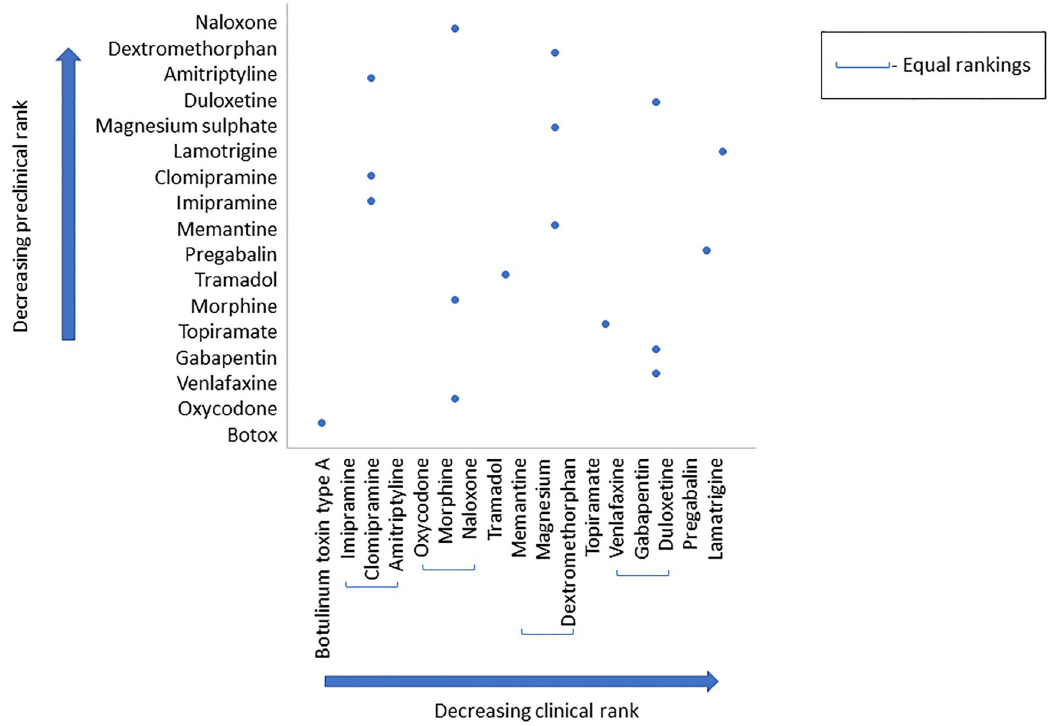
Fig 11. Rank order of clinical and preclinical drugs (data set 2a). A Spearman’s correlation was run to assess the relationship between clinical and preclinical rank of 17 drugs. There was no correlation between clinical and preclinical rank; r s = − 0.0099, p =